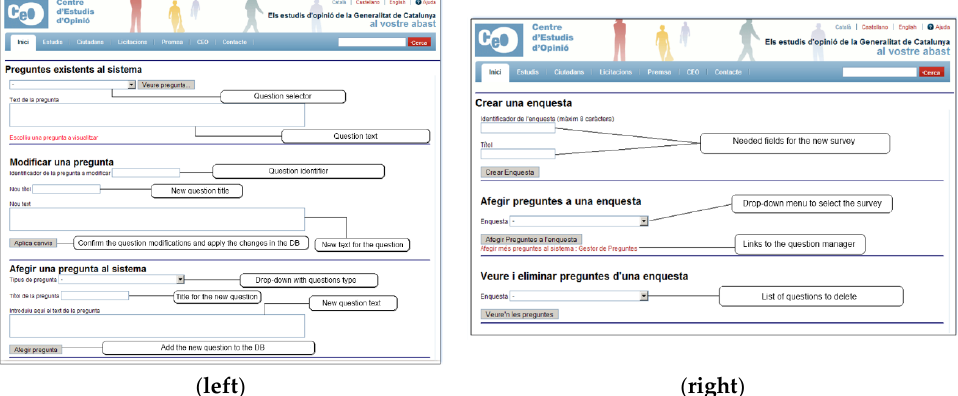
Figure 5. The process of creating a new question ( left ) or a new survey ( right ) is integrated into the application, simplifying the process of reuse and relating the questions of all the questionnaires that exist in the system, as proposed by our approach.